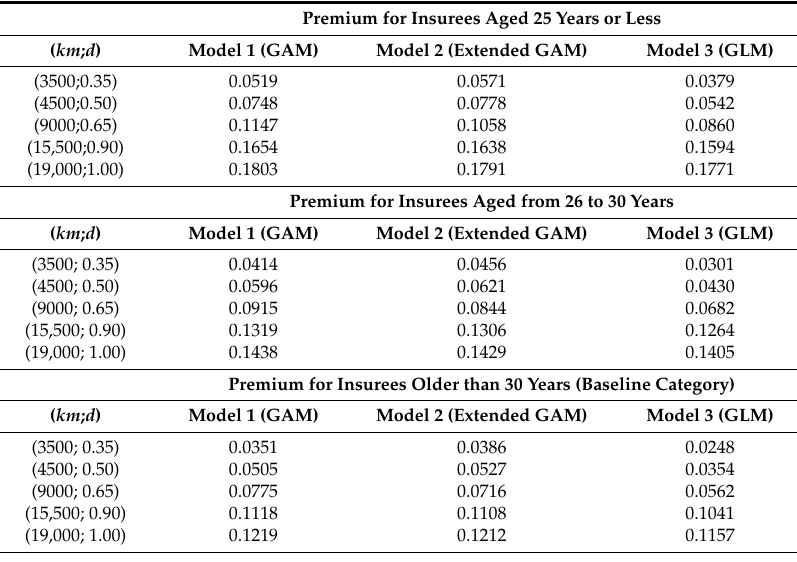
Table 10. Estimated premiums for the three models by age